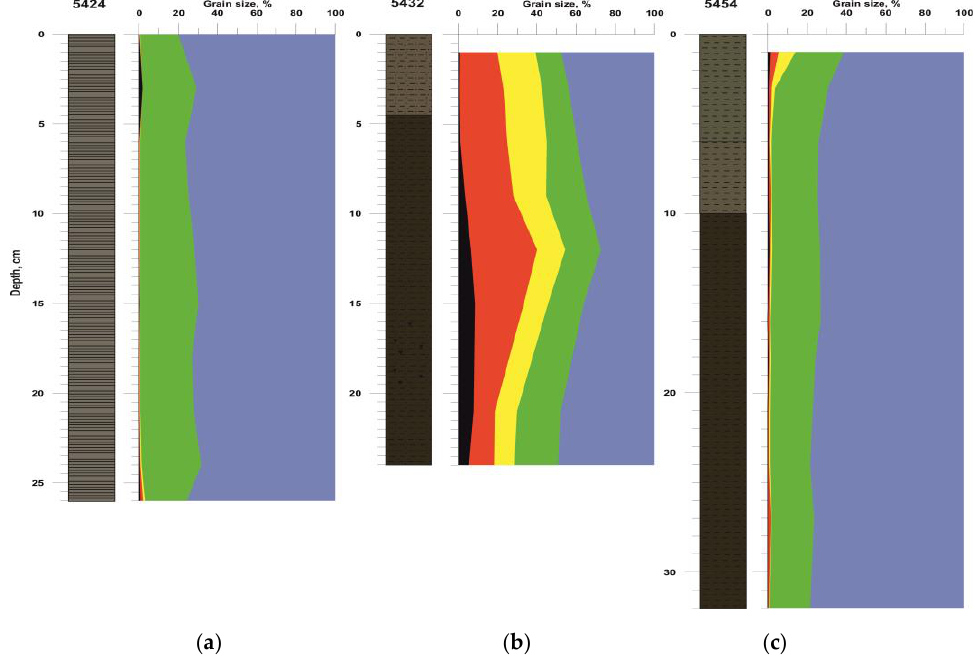
Figure 23. Lithology and grain-size distribution in the modern sediments cores, AMK-5424 ( a ), AMK-5432 ( b ), and AMK-5454 ( c ). For symbols, see Figure 2.